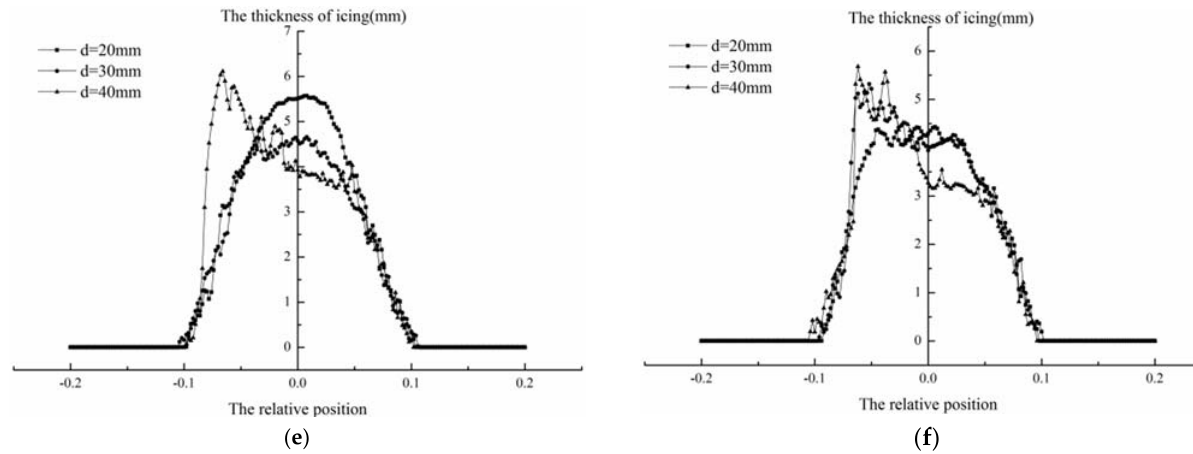
Figure 16. Variation of the thickness of ice layer along the cylinder surface: ( a ) λ = 0.2; ( b ) λ = 0.6; ( c ) λ = 1.0; ( d ) λ = 1.5; ( e ) λ = 2.5; ( f ) λ = 3.5.